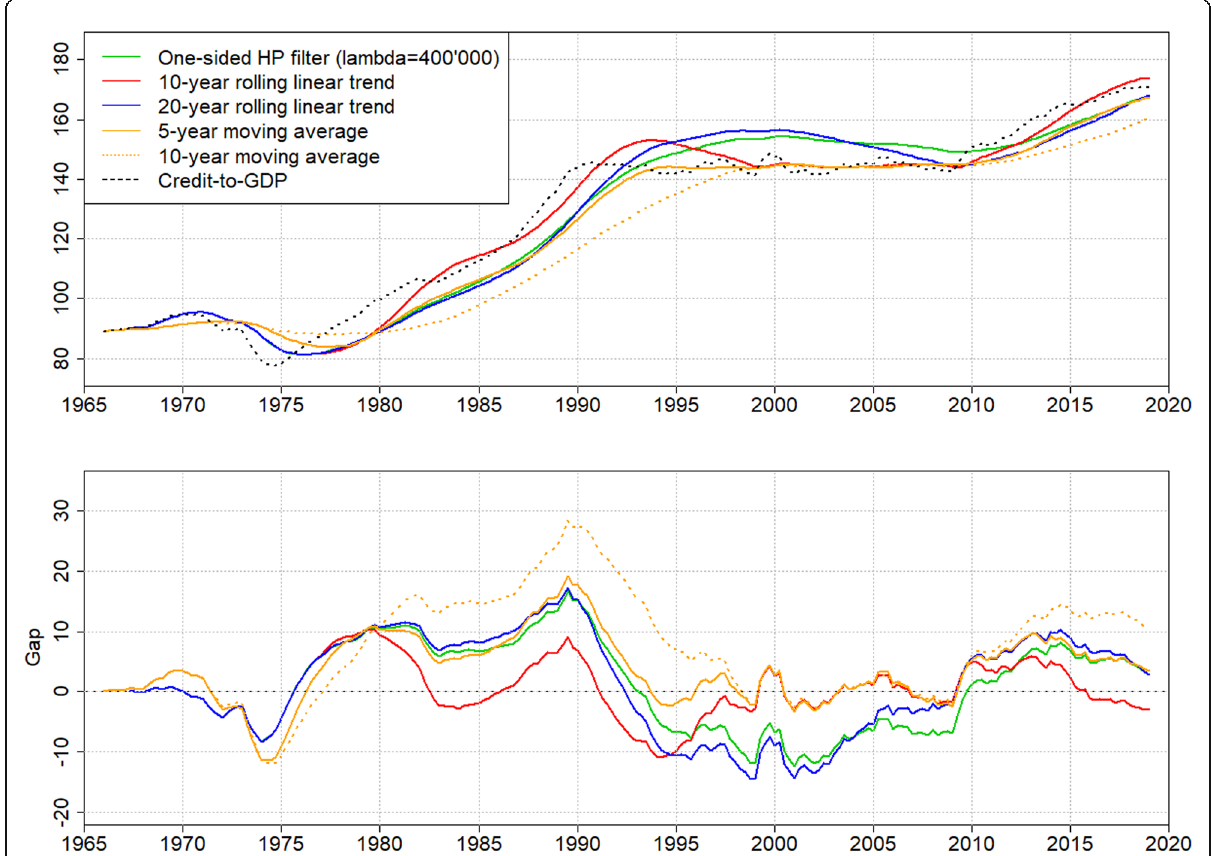
Fig. 13 Alternative trends (upper panel) and gap estimates (lower panel). Note: 10- and 20-year rolling linear trends are obtained by running linear regressions applied over 10- and 20-year rolling windows. The 5- and 10-year moving averages are simple moving average values with 5- and 10-year rolling windows. Only the last points are reported to obtain real-time